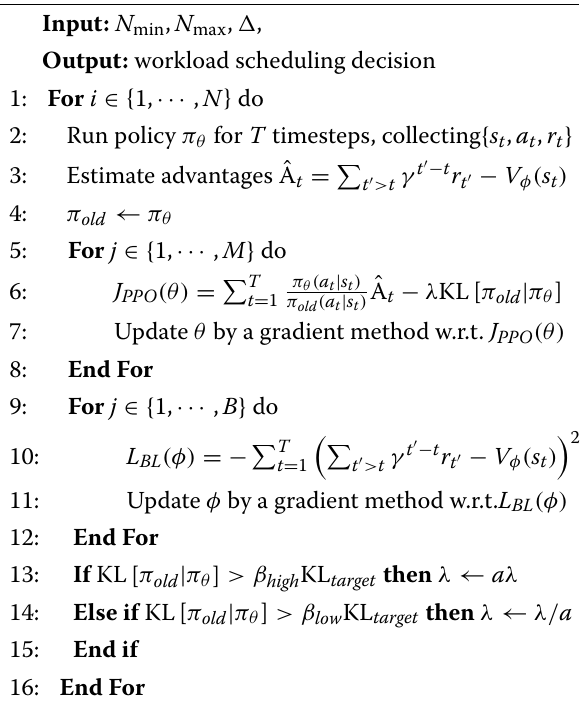
Algorithm 3 PPO-based Workload Scheduling Algorithm